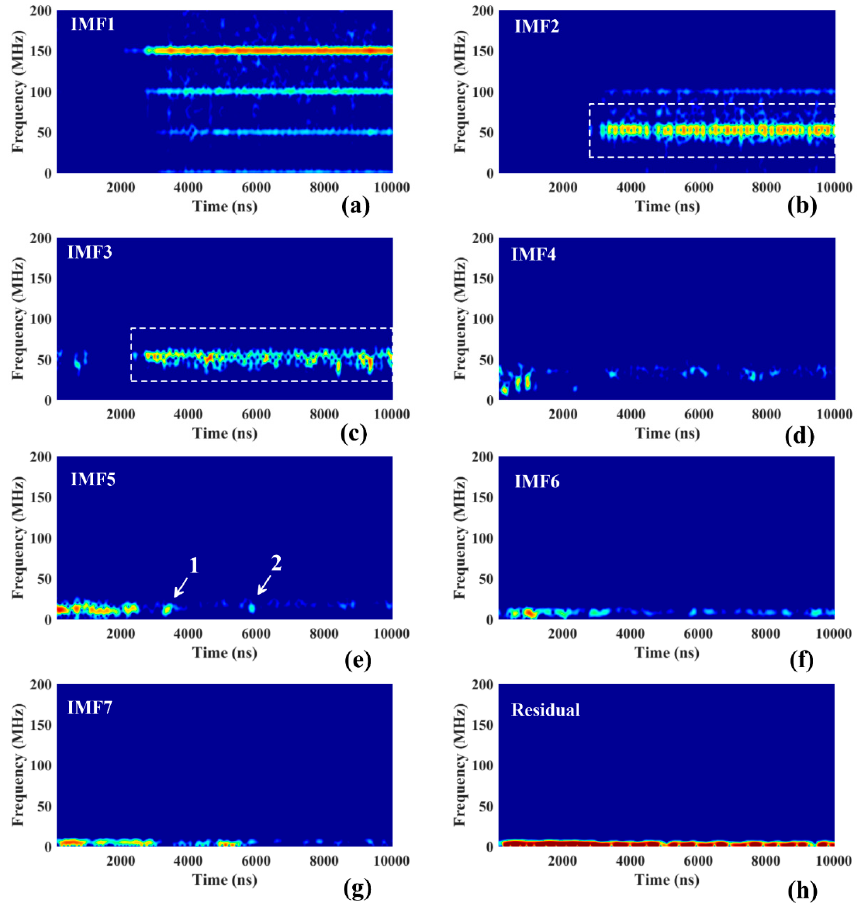
Figure 8. Time–frequency spectrum of each intrinsic mode function (IMF) decomposed from the trace at N104. ( a ) IMF1. ( b ) IMF2. ( c ) IMF3. ( d ) IMF4. ( e ) IMF5. ( f ) IMF6. ( g ) IMF7. ( h ) Residual.